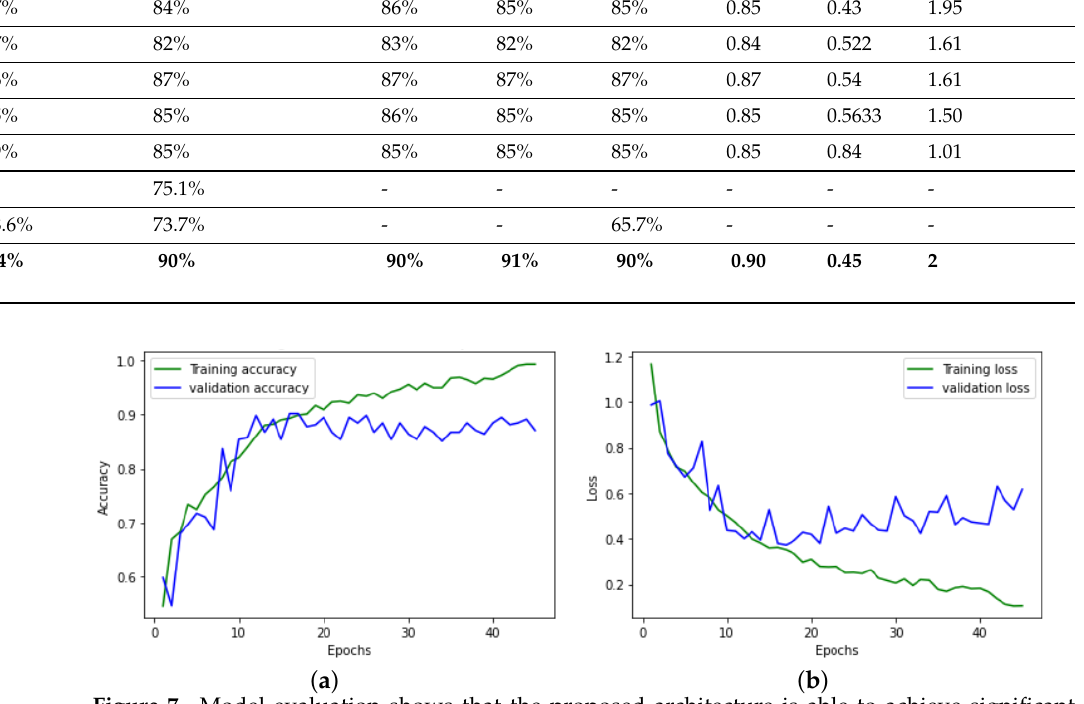
Figure 7. Model evaluation shows that the proposed architecture is able to achieve significant validation accuracy ≈ 90% with very low error. ( a ) Training and validation accuracy. ( b ) Training and validation